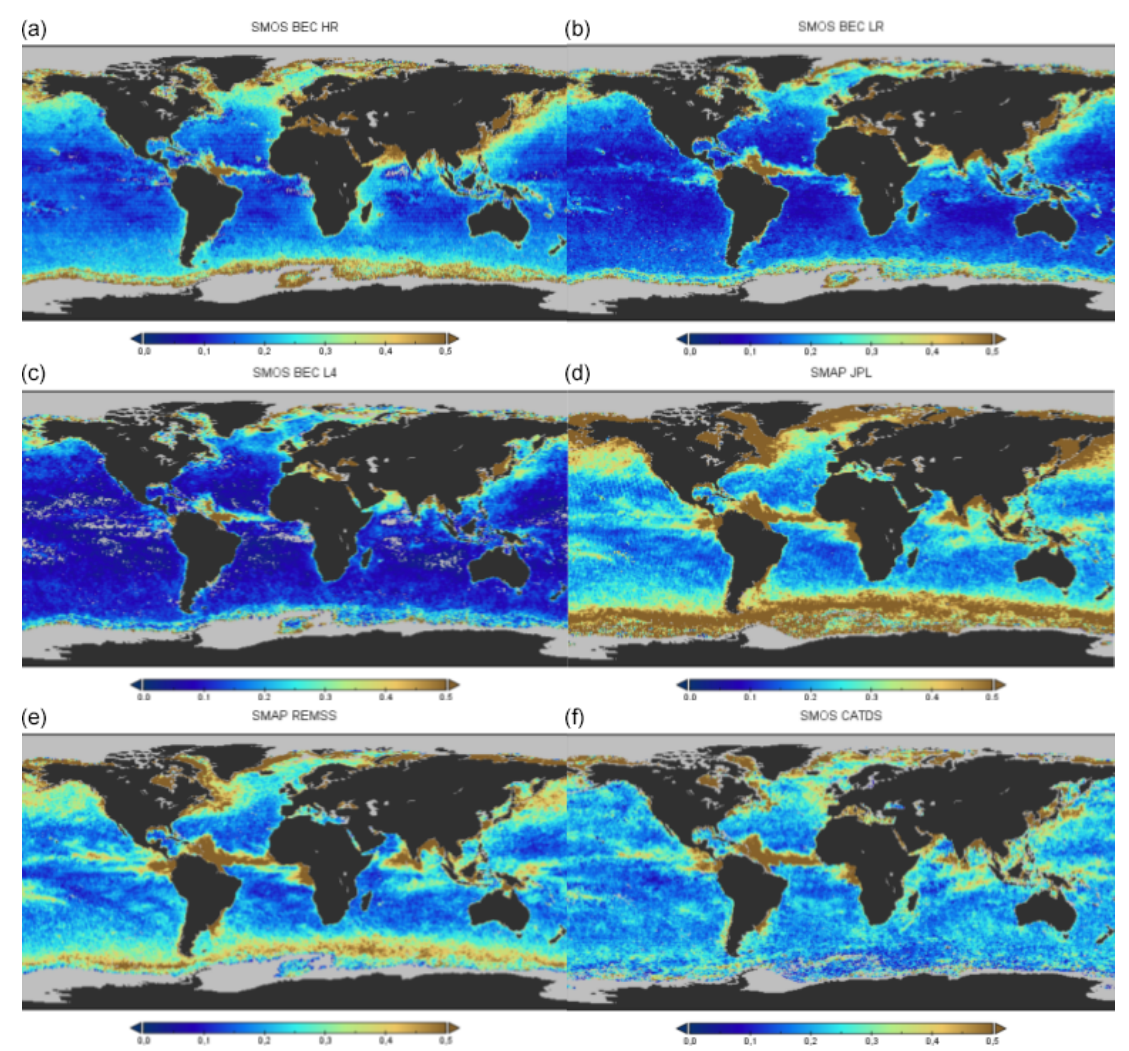
Figure 17. SSS error estimation by triple collocation, from top to bottom and left to right: BEC HR, BEC LR, BEC L4, JPL, REMSS, and